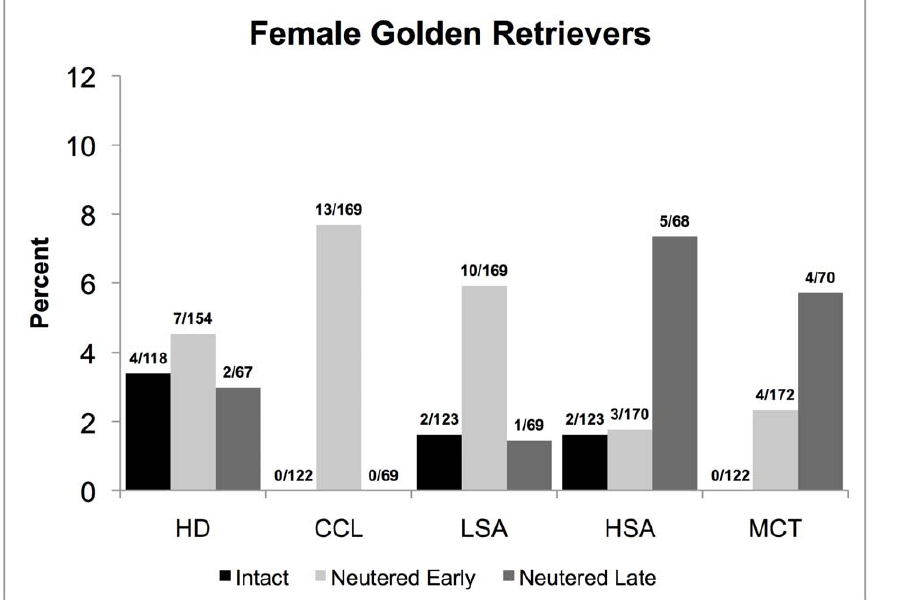
Figure 2. Percentages and number of cases over the total sample size for each neutering status group; intact and neutered early or late for female Golden Retrievers (1–8 years old) diagnosed with hip dysplasia (HD), cranial cruciate ligament tear (CCL), lymphosarcoma (LSA), hemangiosarcoma (HSA), and/or mast cell tumor (MCT) at the Veterinary Medical Teaching Hospital of the University of California, Davis, from 2000–2009. For CCL the difference between intact and early-neutered was statistically significant (K-M). For HSA, the differences between early and late-neutered and intact and late-neutered groups were statistically significant (RR), as were differences for MCT between early and late-neutered groups. A similar statistical comparison for late neutering and intact groups was not possible for MCT because there were 0 cases in the intact group.